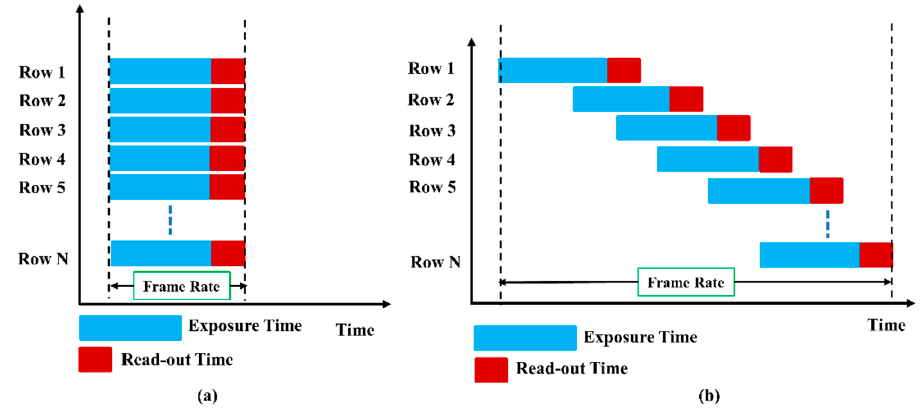
Figure 4. ( a ) Global shutter effect of CCD sensor; ( b ) rolling shutter effect of CMOS sensor.